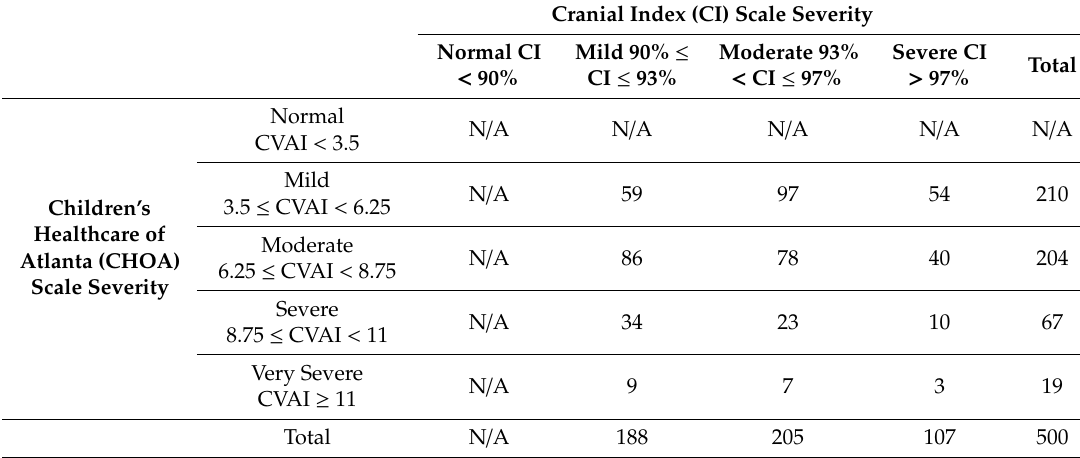
Table 1. Number of infants within each cranial severity category at the start of treatment based on the initial cranial vault asymmetry index (CVAI) and cephalic index